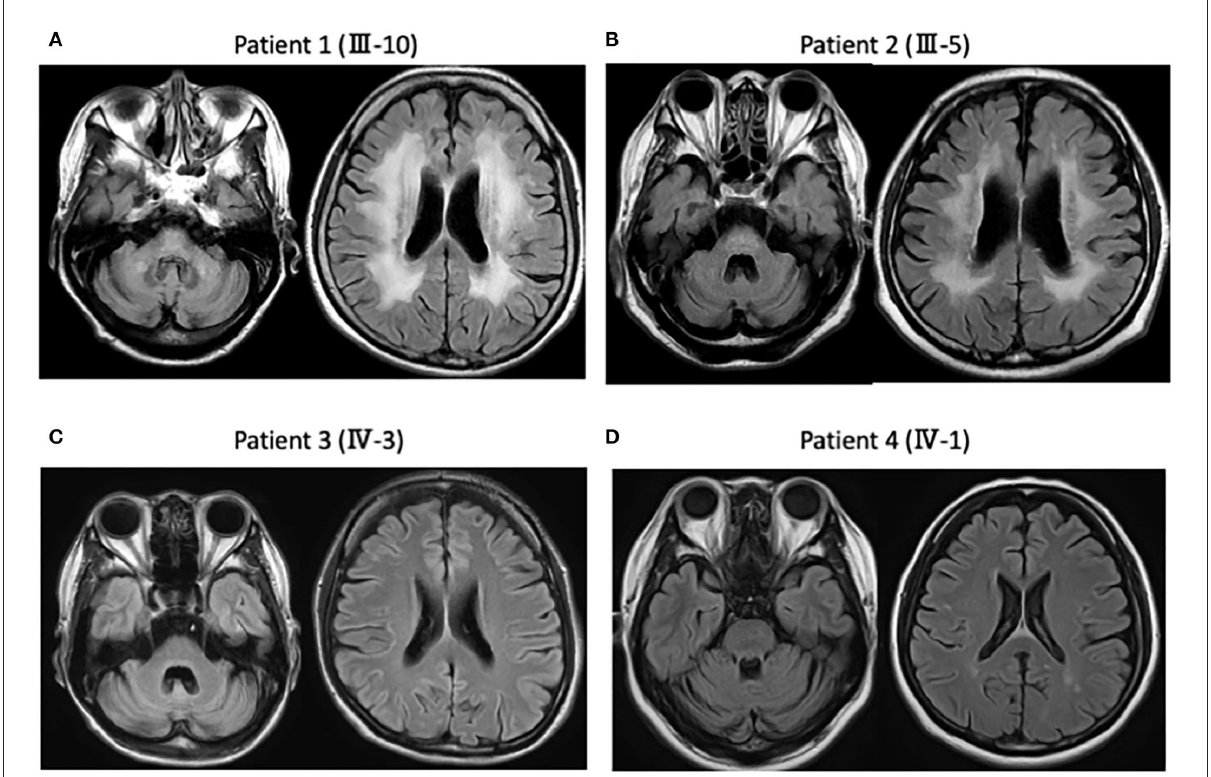
FIGURE2 Magnetic resonance imaging (MRI) findings in the present four patients. (A) Patient 1 (III-10). Fluid attenuated inversion recovery images of the MRI show diffuse cerebellar and brainstem atrophy, as well as high-intensity signals in the diffuse periventricular white matter. (B) Patient 2 (III-5). MRI shows diffuse cerebellar and brainstem atrophy, as well as high-intensity signals in the diffuse periventricular white matter. (C) Patient 3 (IV-3). MRI shows diffuse cerebellar and brainstem atrophy without white matter changes. (D) Patient 4 (IV-1). MRI shows diffuse cerebellar atrophy without periventricular white matter